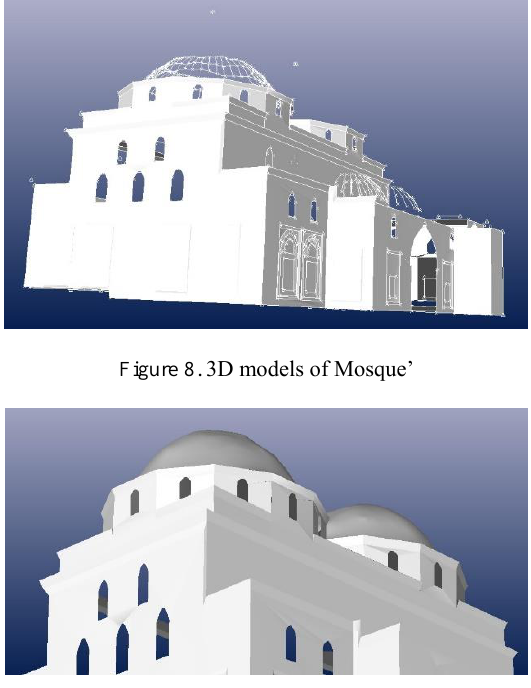
Figure 9. 3D models of